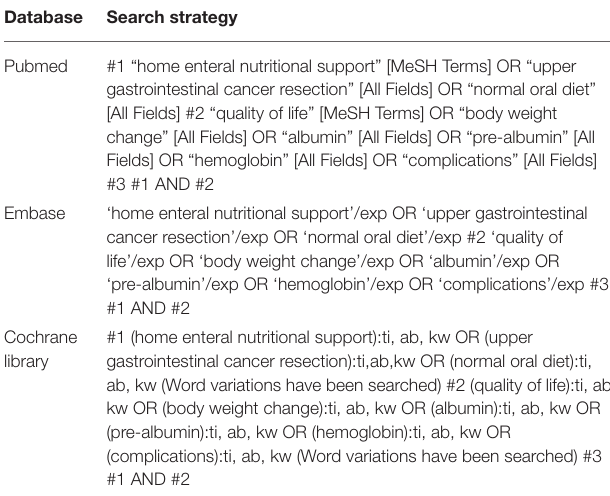
TABLE 1 | Search strategy for each database. TABLE 2 | Characteristics of the selected studies for the meta-analysis.